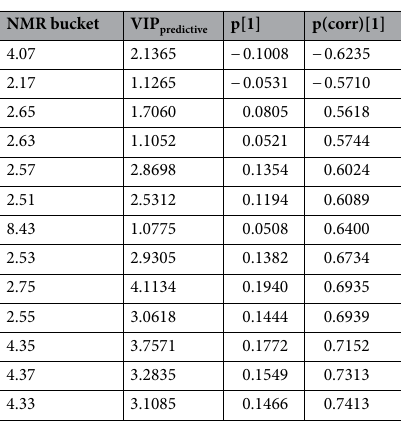
Table 2. Selected NMR variables related to metabolites with the highest potential as biomarkers (VIP predictive > 1.0 and |p(corr)|> 0.5). NMR data derives from the analysis of olive leaf